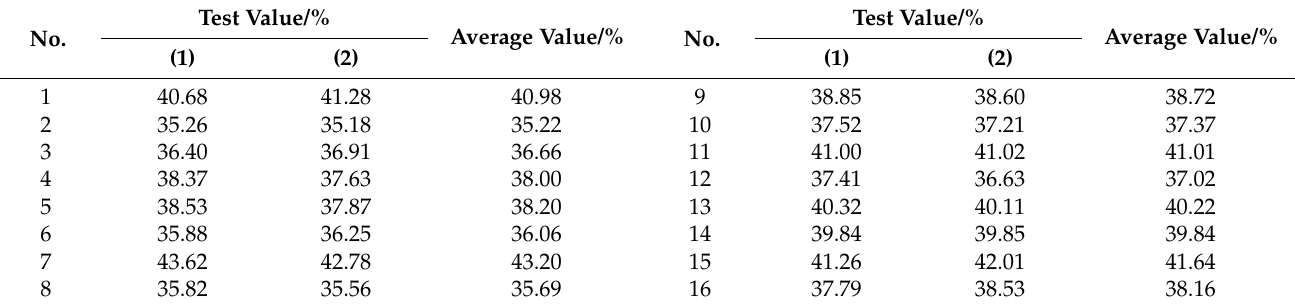
Table 3. VCA values of hybrid coarse aggregates.